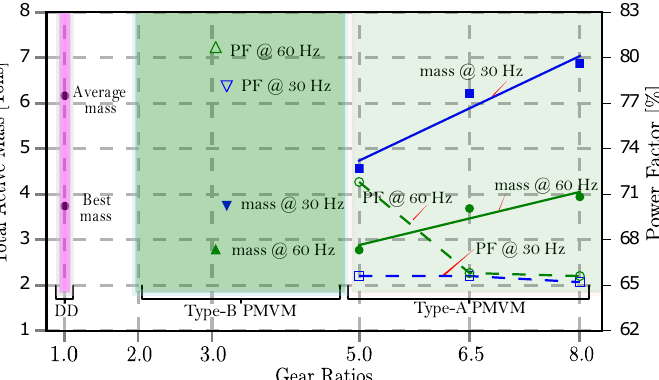
Figure 14. Total active mass and power factor vs. gear ratios for 1MW machines (©[2020] IEEE. Reprinted, with permission from [20]).